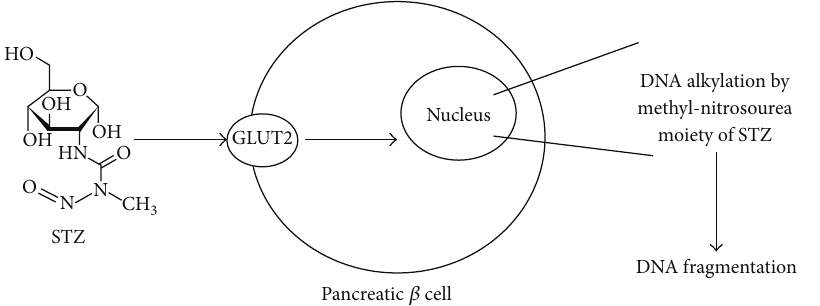
Figure 2: The mechanism of action of streptozotocin (STZ) in 𝛽